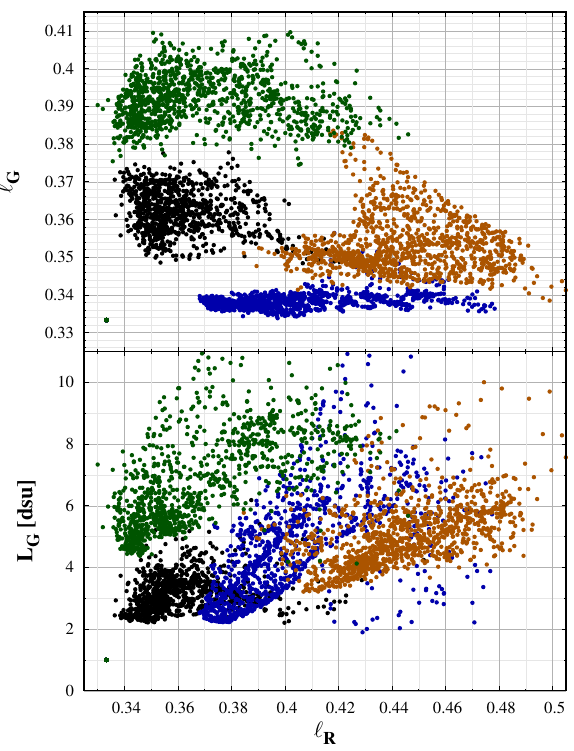
Figure 4. Colour–colour ( top ) and colour–radiance ( bottom ) diagram calculated from all-sky images taken at worldwide locations. Black: remote location in Canada, natural sky; Green: El Malpais National Monument, NM, USA, some light pollution, strong green airglow; Orange: Cosmic Campground Dark Sky Sanctuary, NM, USA, no ALAN, strong sodium airglow; Blue: Zselic, some medium level ALAN, best night with